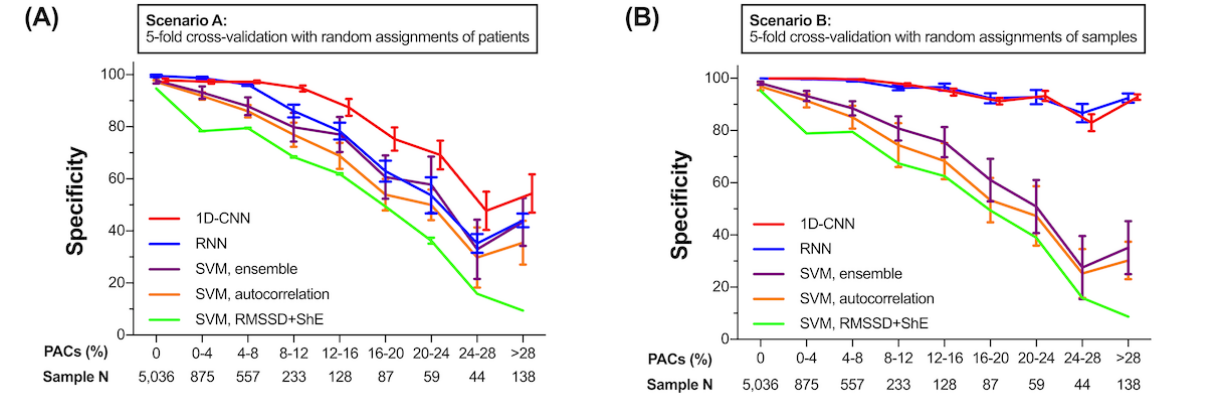
Figure 4. Comparison of performances of deep learning classifiers and previous state-of-the-art atrial fibrillation detectors by premature atrial complexes (PACs) burden. The performance of classifying photoplethysmography samples during post- direct-current cardioversion period as sinus rhythm by each algorithm was measured by specificity. (A) Scenario A was obtained by the 5-fold cross-validation with random assignment of patients. In this case, each algorithm faced new patient’s data during testing. (B) Scenario B was obtained by the 5-fold cross-validation with random assignment of samples. This approach assumed that the training distribution could emulate the test distribution. Regardless of the method, both 1-dimensional convolutional neural network and recurrent neural network maintained higher specificity over burden of PACs. Both DL classifiers showed higher specificity in Scenario B than Scenario A. 1D-CNN: 1-dimensional convolutional neural network; PAC: premature atrial complex; PPG: photoplethysmography; RNN: recurrent neural network root-mean square of successive difference of RR